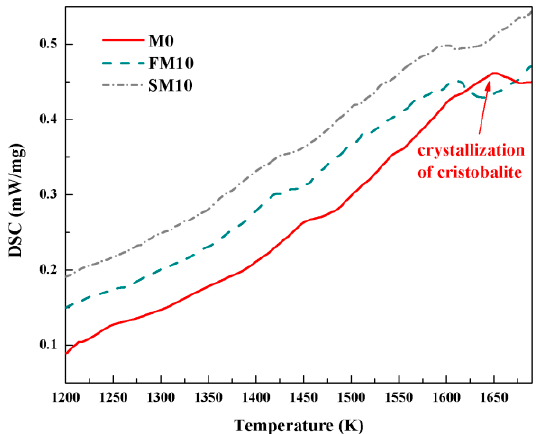
Figure 3. DSC curves for different ceramic cores.